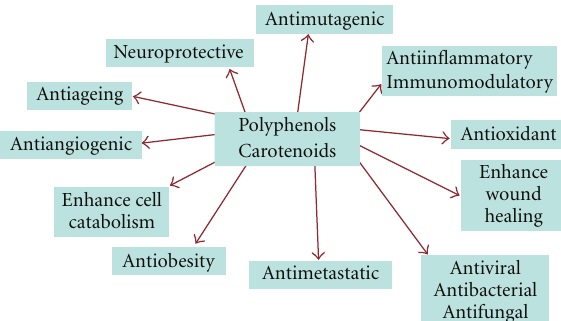
Figure 6: General biological activities of polyphenols & caroten-